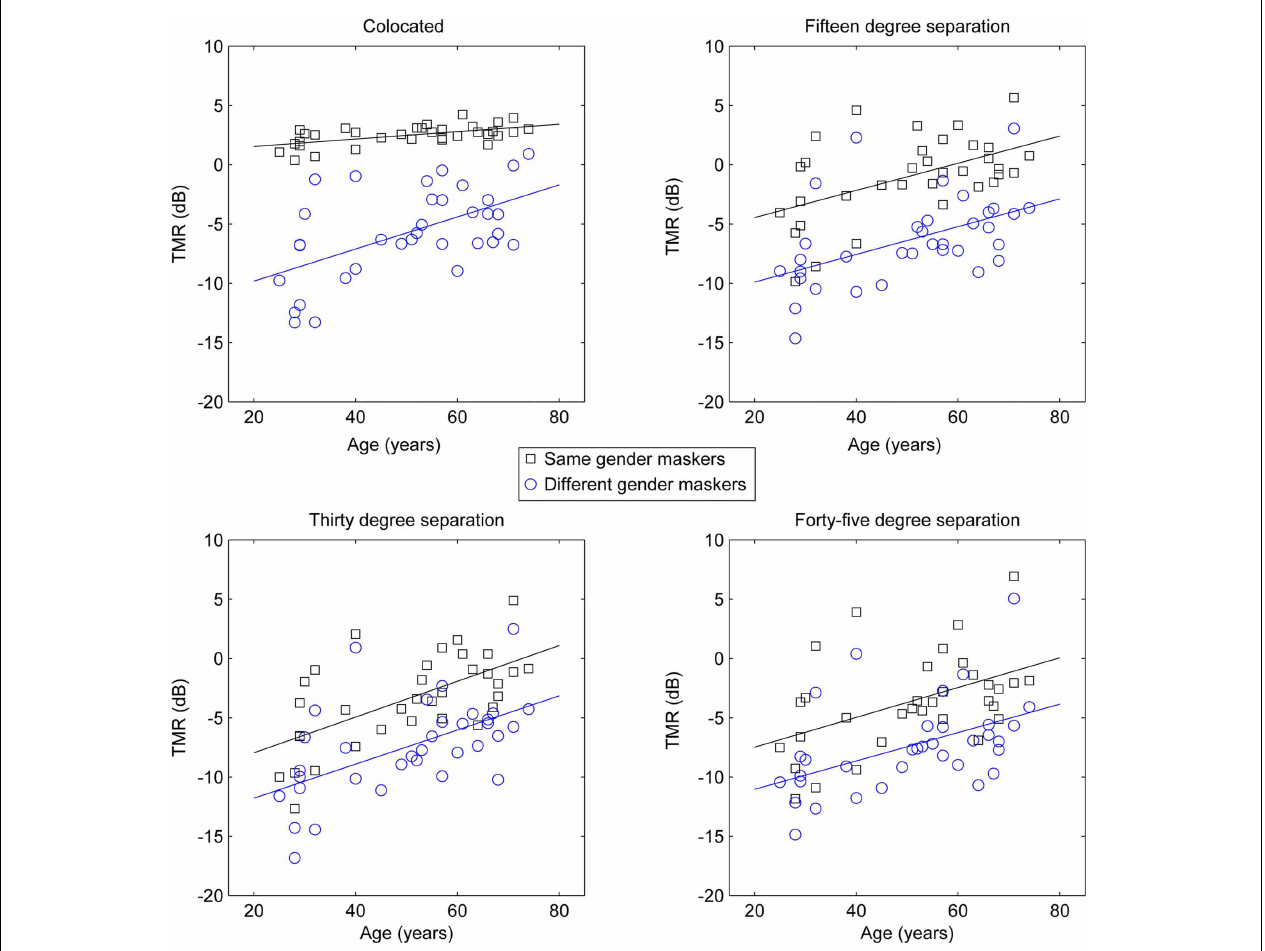
FIGURE 2 | Target-to-masker ratio (TMR) plotted as a function of age for the subjects in Experiment One. Each panel plots same-gender maskers (averaged across target gender) as squares and different-gender maskers as circles.